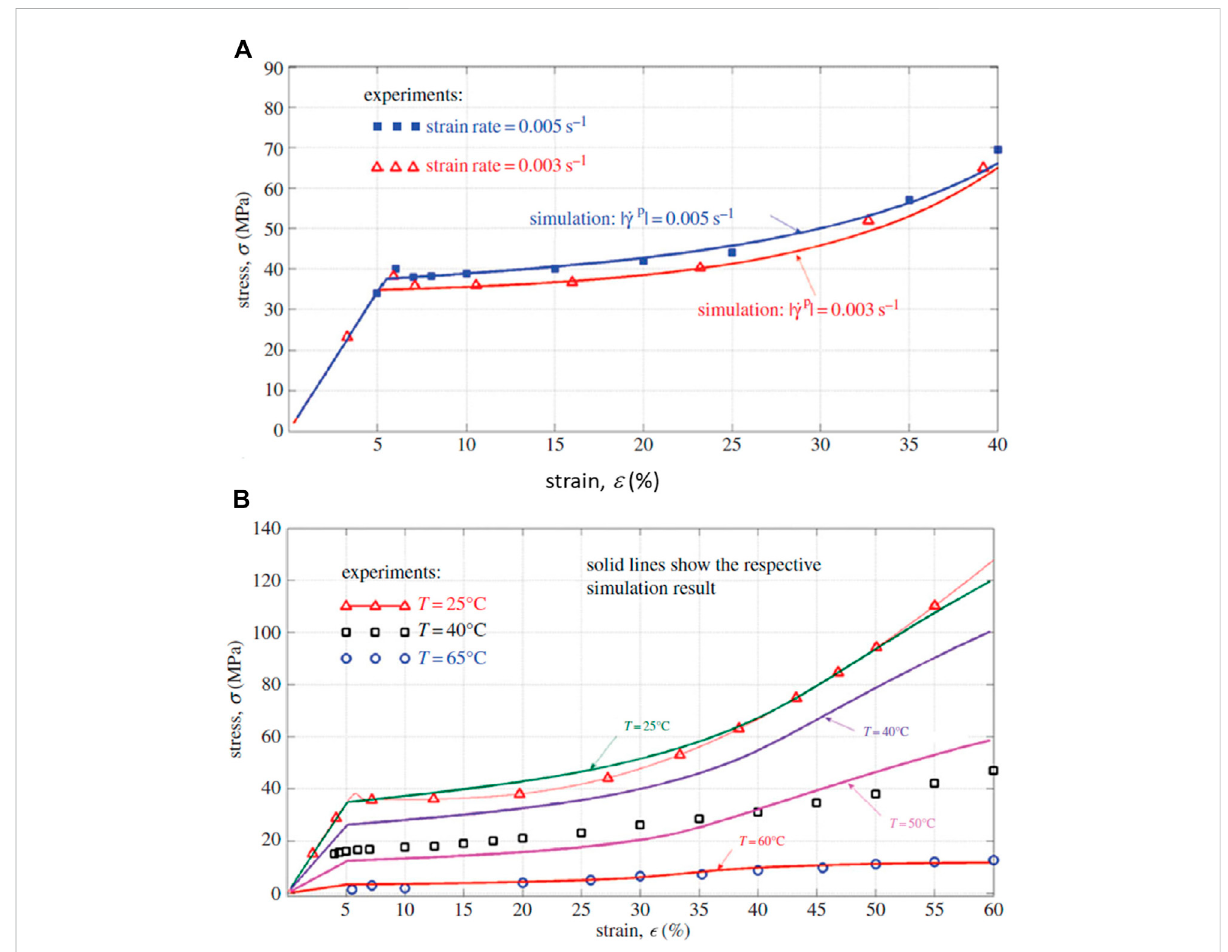
FIGURE 15 Comparison of experimental and simulation results for the viscoplastic stress – strain responses to (A) rate and (B) temperature (Shojaei and Li, 2014). [Reproduced with permission from Proceedings of the Royal Society A, 470: 20140199., (2014). Copyright 2014 Royal